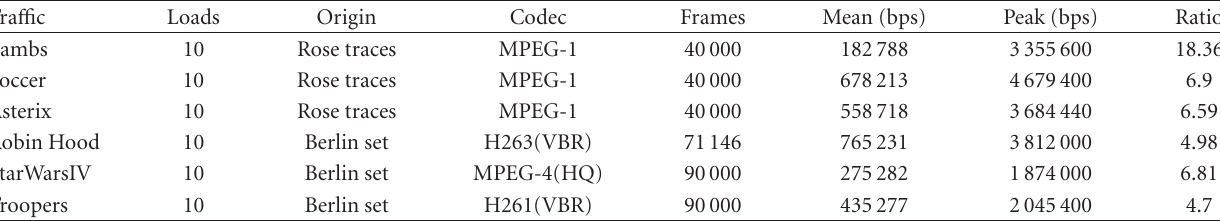
Table 1: Workload for static tra ffi c